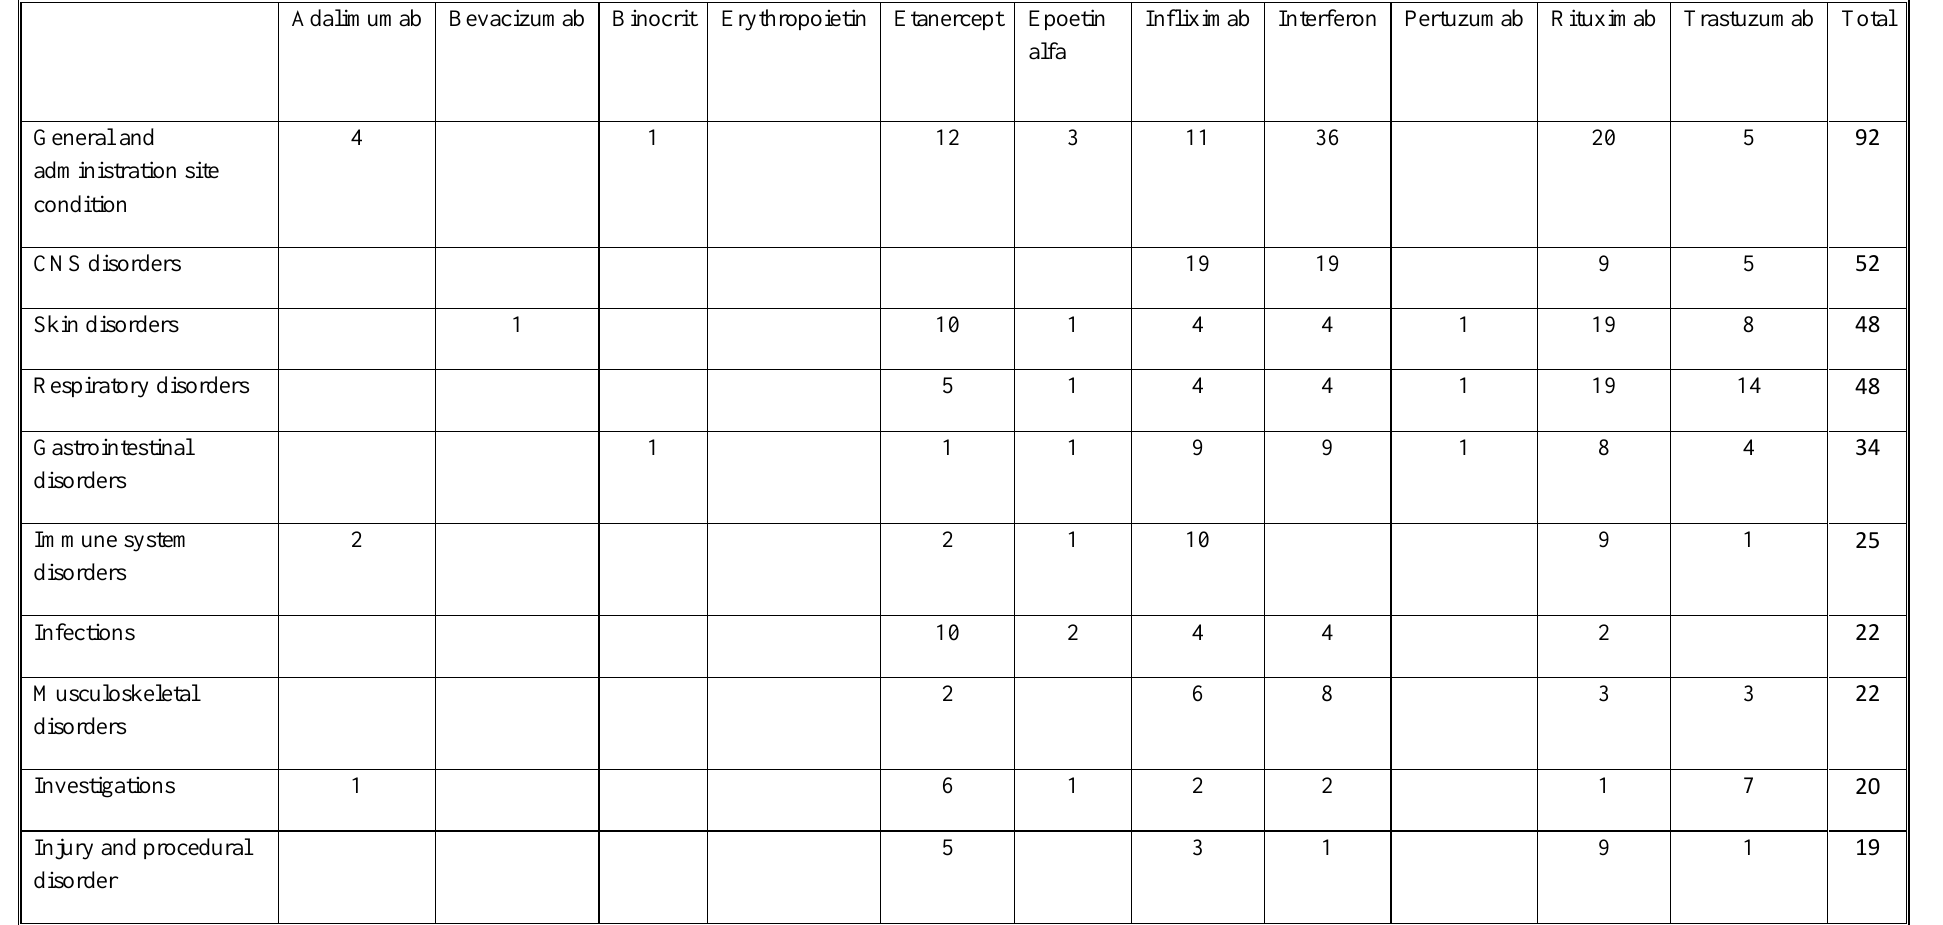
Infliximab Interferon Total alfa